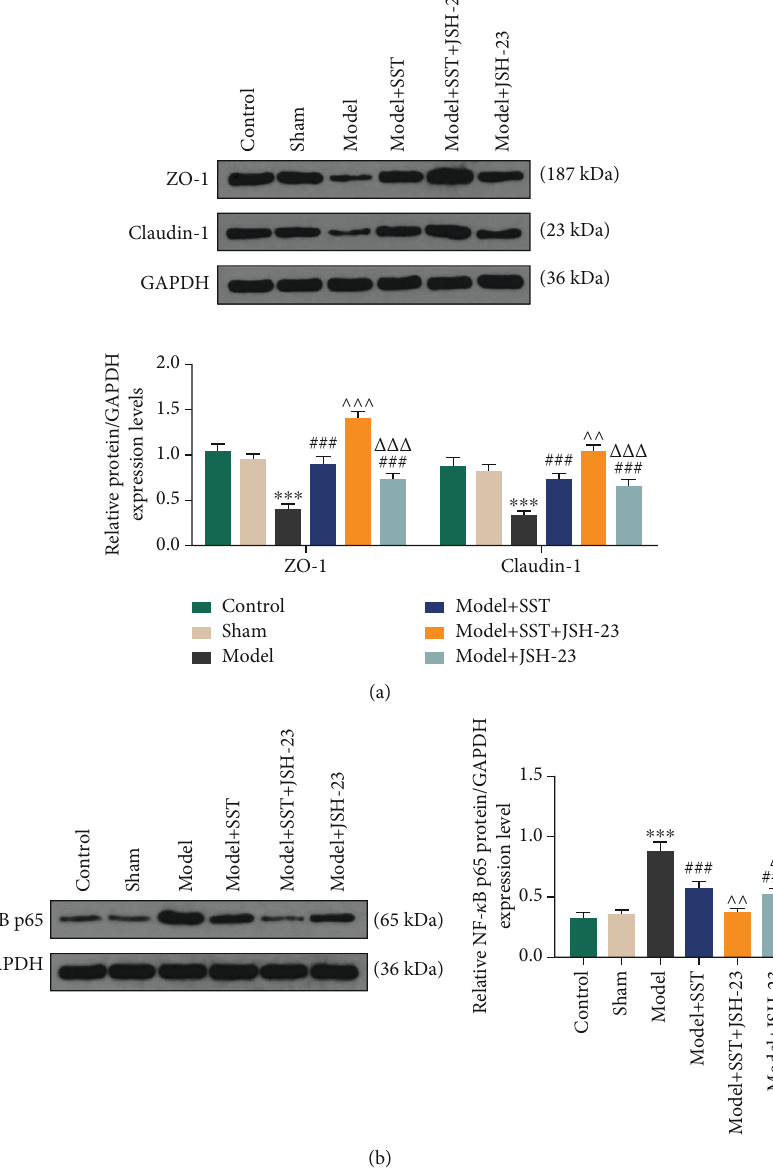
Figure 4: JSH-23 enhanced the protective e ff ect of SST on the decrease of sepsis-induced tight junction protein expressions: (a) western blot analysis of tight junction proteins, ZO-1 and Claudin-1, in the ileum; (b) western blot analysis of NF- κ B p65 in the ileum. Data were shown as the mean ± SD from 3 independent experiments. ∗∗∗ P < 0 : 001 , vs. sham; ### P < 0 : 001 , vs. model. ^^ P < 0 : 01 and ^^^ P < 0 : 001 , vs. model+SST. △ P < 0 : 05 and △△△ P < 0 : 001 , vs. model+SST+JSH-23. SST: